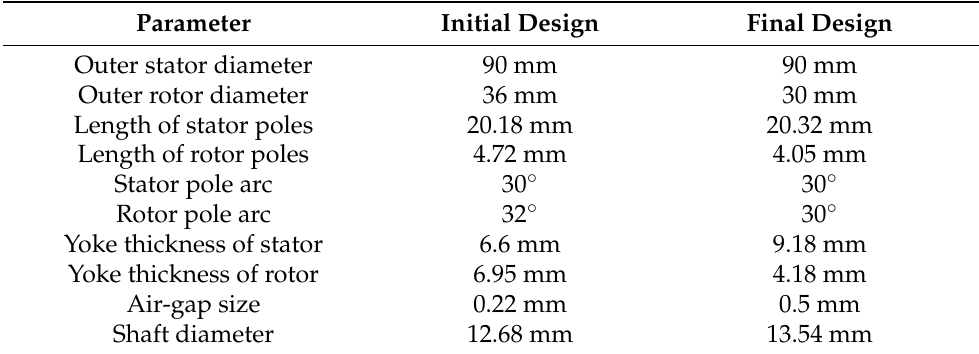
Table 9. Comparison of the geometric parameters.